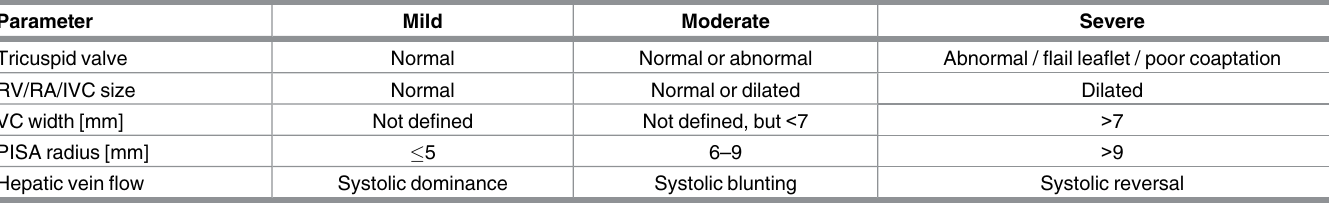
Table 1. Echocardiographic parameters used for grading of tricuspid regurgitation severity